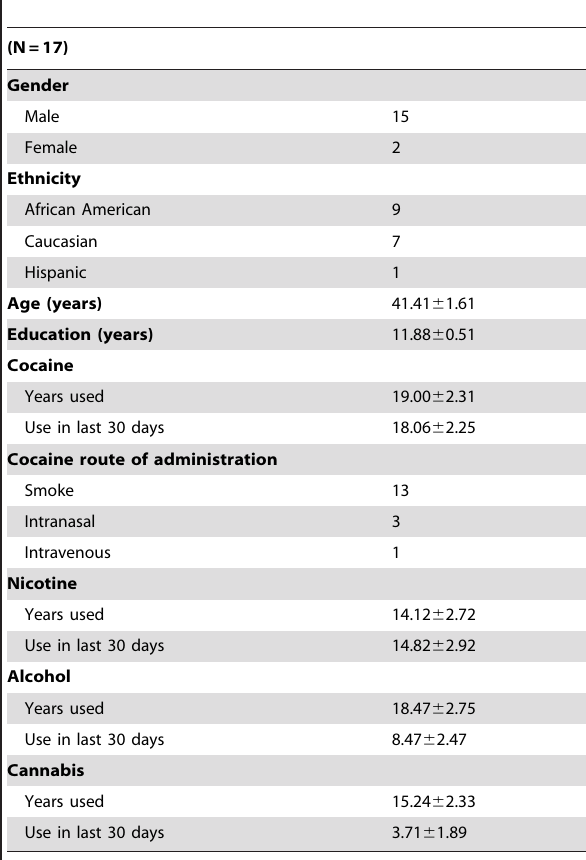
Table 2. Participant demographics and drug use.